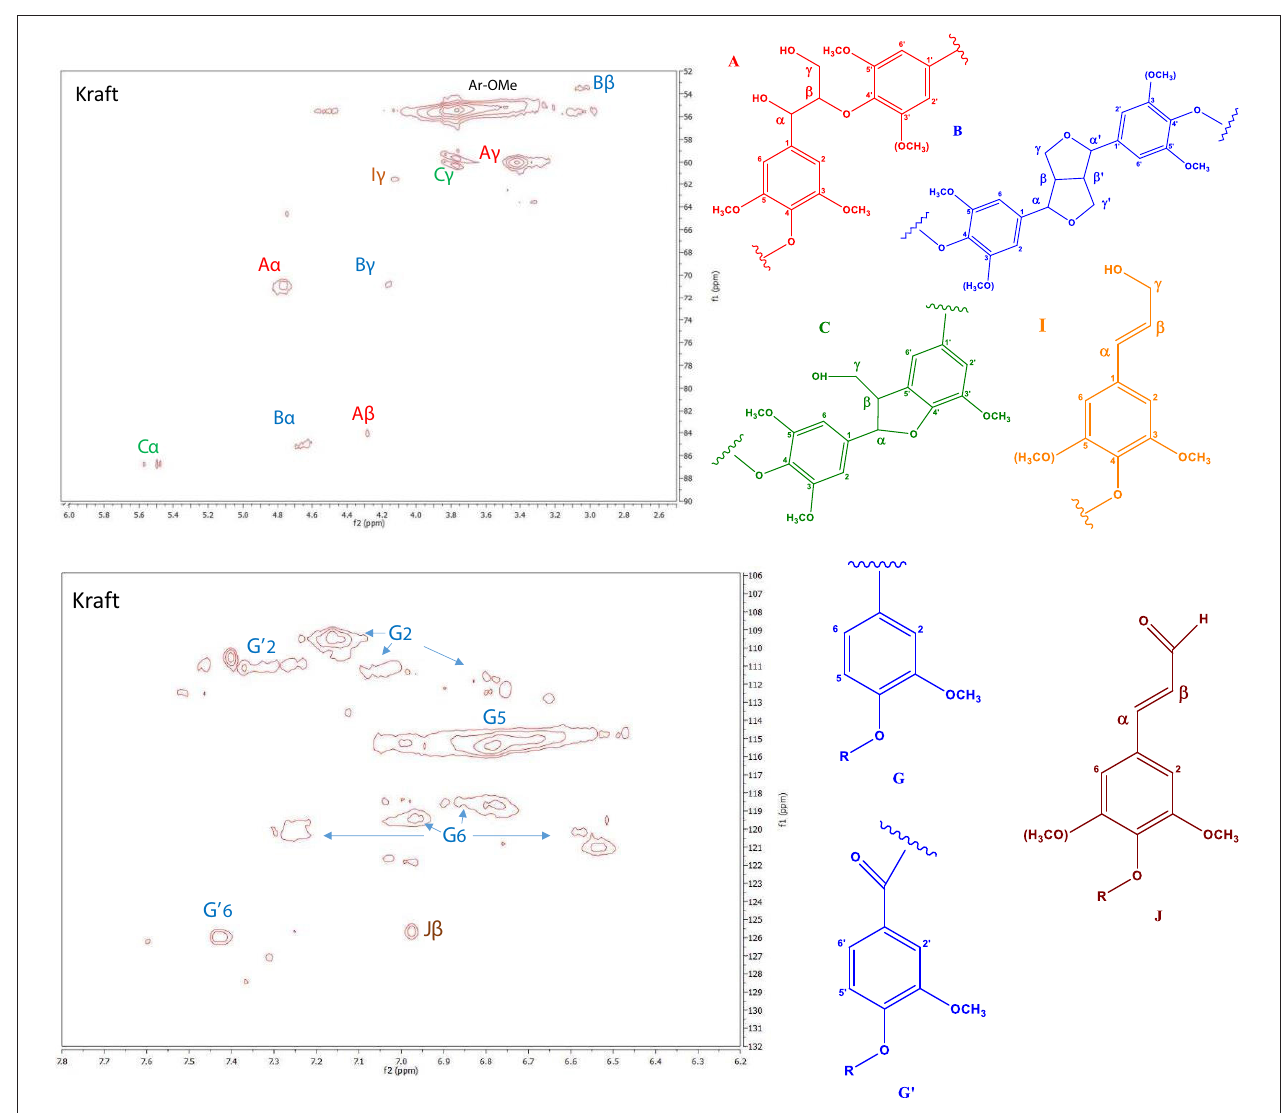
FIGURE 2 | Side-chain ( top ) and aromatic regions ( bottom ) in the 2D HSQC NMR spectra of kraft lignin.